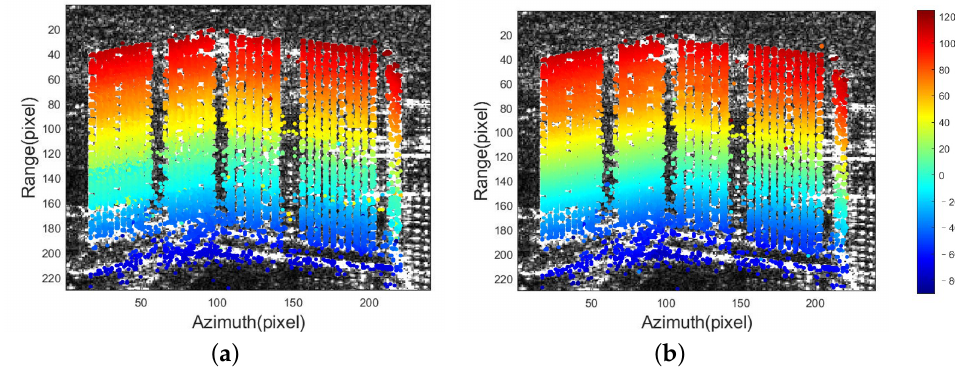
Figure 14. Tomographic reconstruction results of Hubei Science and Technology Venture Building. The color represents different elevation. ( a ) Tomo-ANM. ( b )